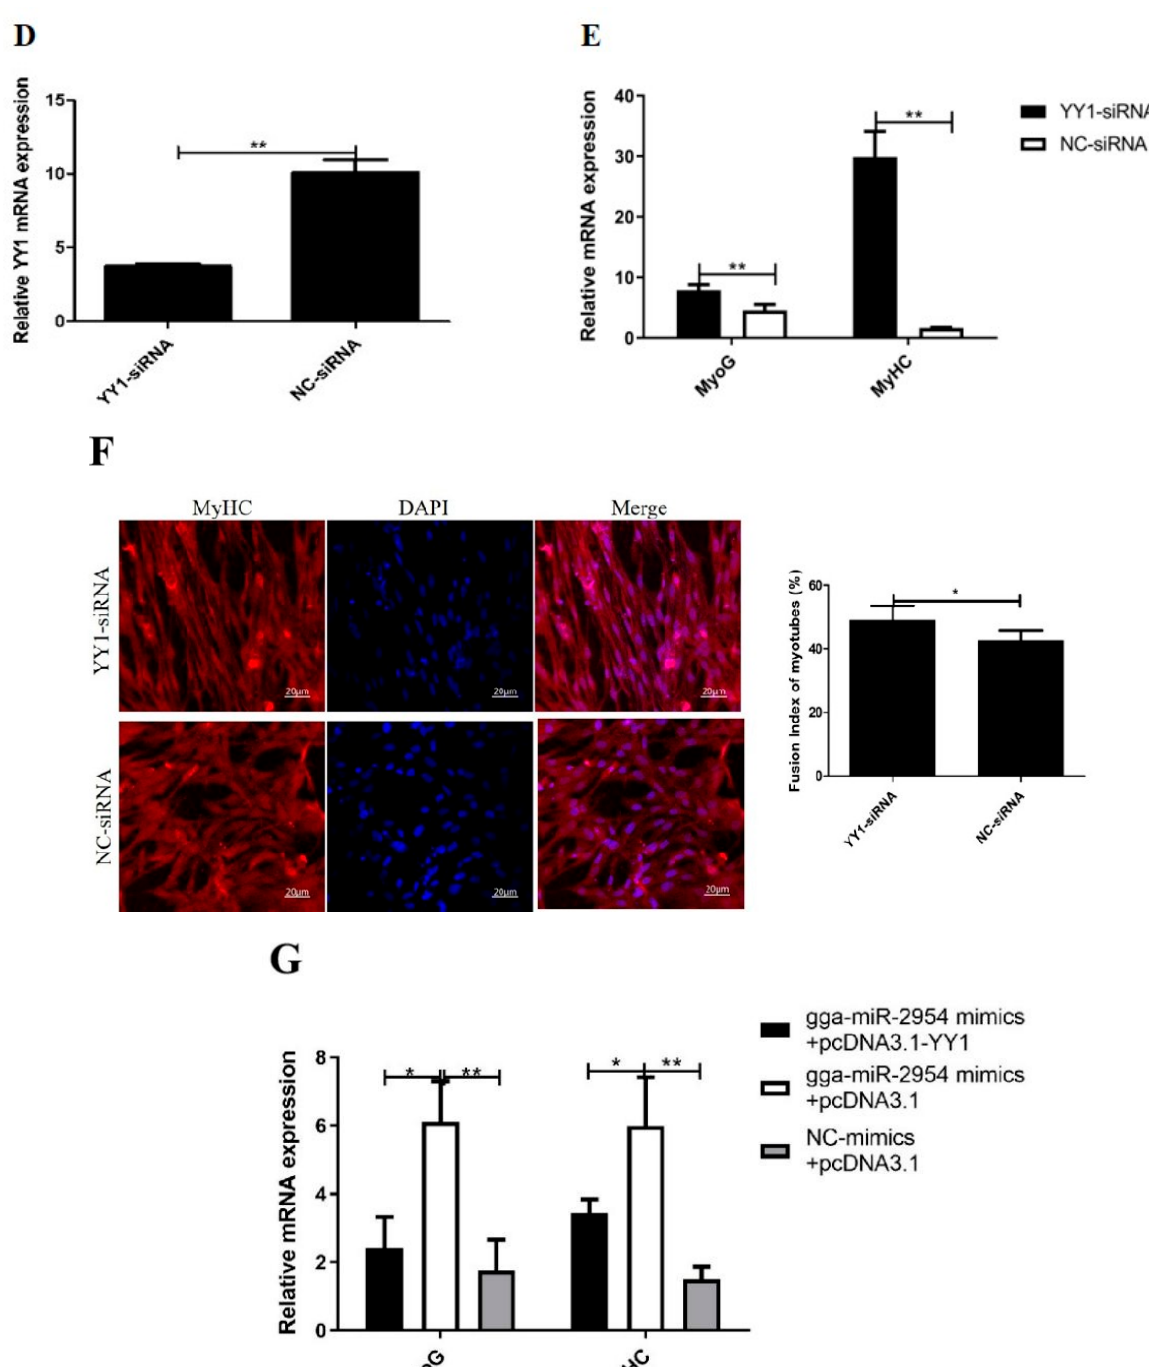
Figure 7. Gga-miR-2954 promotes myogenic differentiation by targeting YY1 . ( A ) The expression efficiency of pcDNA3.1-YY1 in differentiated myoblasts. ( B )The mRNA expression of MyoG and MyHC after YY1 overexpression. ( C ) The results of MyHC immunofluorescence staining after YY1 overexpression. Scale bar = 20 µ m. ( D )The expression efficiency of YY1-siRNA in differentiated myoblasts. ( E )The mRNA expression of MyoG and MyHC after YY1 inhibition. ( F ) The results of MyHC immunofluorescence staining after YY1 inhibition. ( G ) The effect of co-transfection of gga-miR-2954 and YY1 on the expression of myoblast differentiation related genes, MyoG and MyHC . Values represent the mean ± SEM from at least three independent experiments (* P < 0.05; ** P < 0.01).